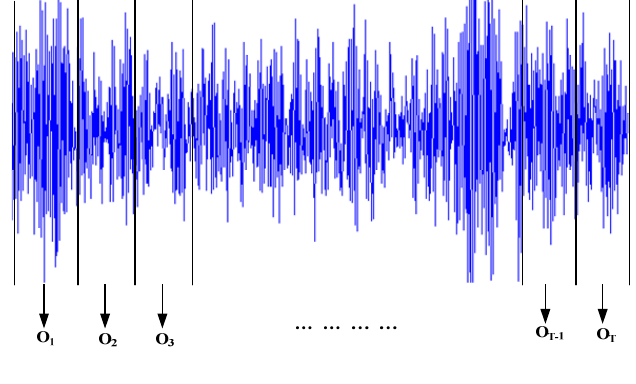
Figure 3. Feature extraction by segmenting the vibration signals into small